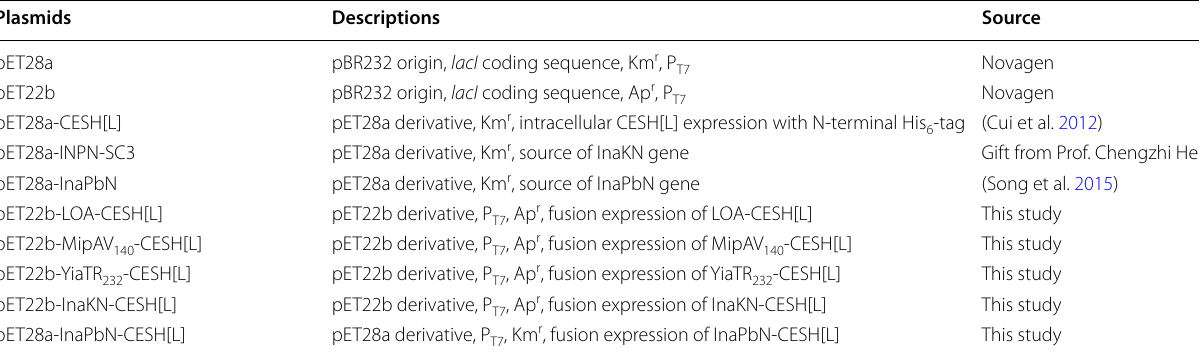
Table 1 Plasmids used in this study Plasmids